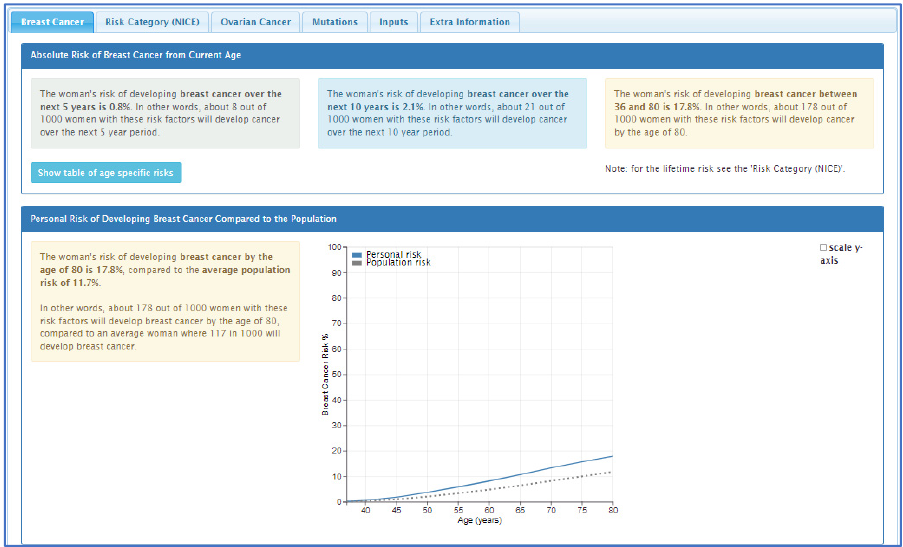
Figure 4. CanRisk tool, results section (post risk calculation).